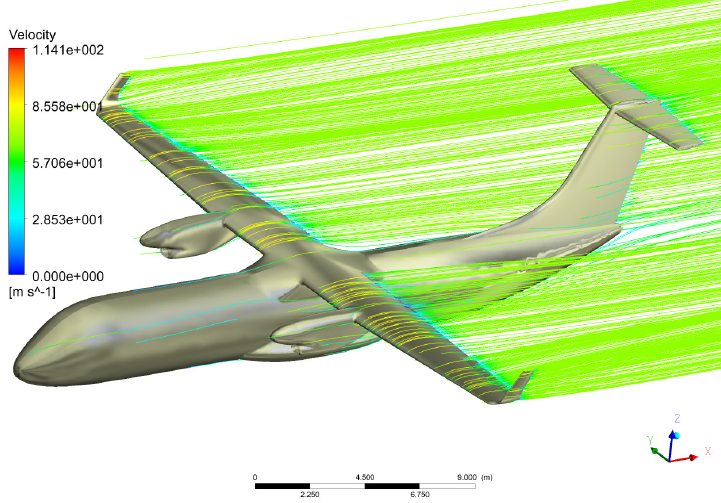
Figure 16. Mean flow streamlines for the configuration with deflected ailerons.